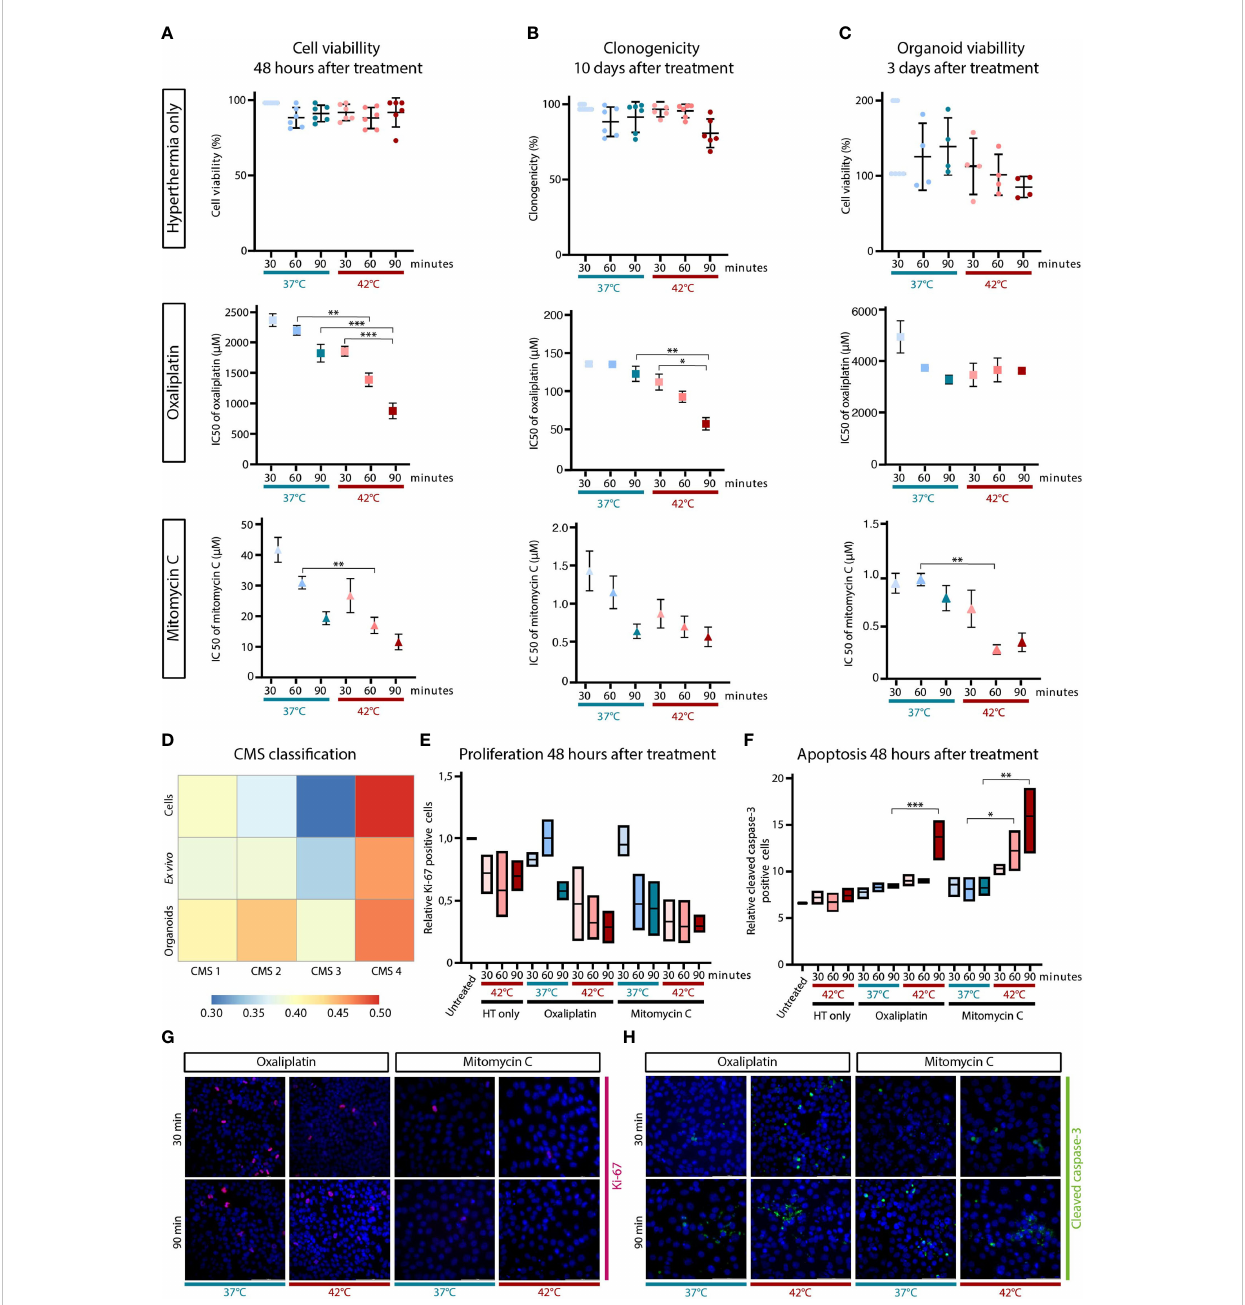
FIGURE 4 Hyperthermia reduces cell viability and clonogenicity, and increases apoptosis in oxaliplatin or mitomycin-C (MMC) treated CC-531 cells. CC-531 cells were exposed to oxaliplatin or MMC under normal (37°C) and hyperthermic (42°C) conditions for 30, 60 or 90 minutes. The effect of hyperthermia only, oxaliplatin and MMC was assessed using cell viability (A) , clonogenic (B) and organoid viability (C) assays performed 48 h, 10 days and 72 h after treatment, respectively. Data represent the means ± SD of 3 independent experiments. RNA sequencing was performed on the CC- 531 cells to de fi ne the CMS subtype (D) . Proliferation (E) and apoptosis (F) levels were studied using immunohistochemistry, which was performed 48 h after treatment. Min/max ± means of 3 independent experiments are presented. Representative pictures are depicted with in pink Ki-67 (G) and in green cleaved caspase-3 (H) positive cells. Signi fi cant p-values are reported as * <0.05, **<0.01 and